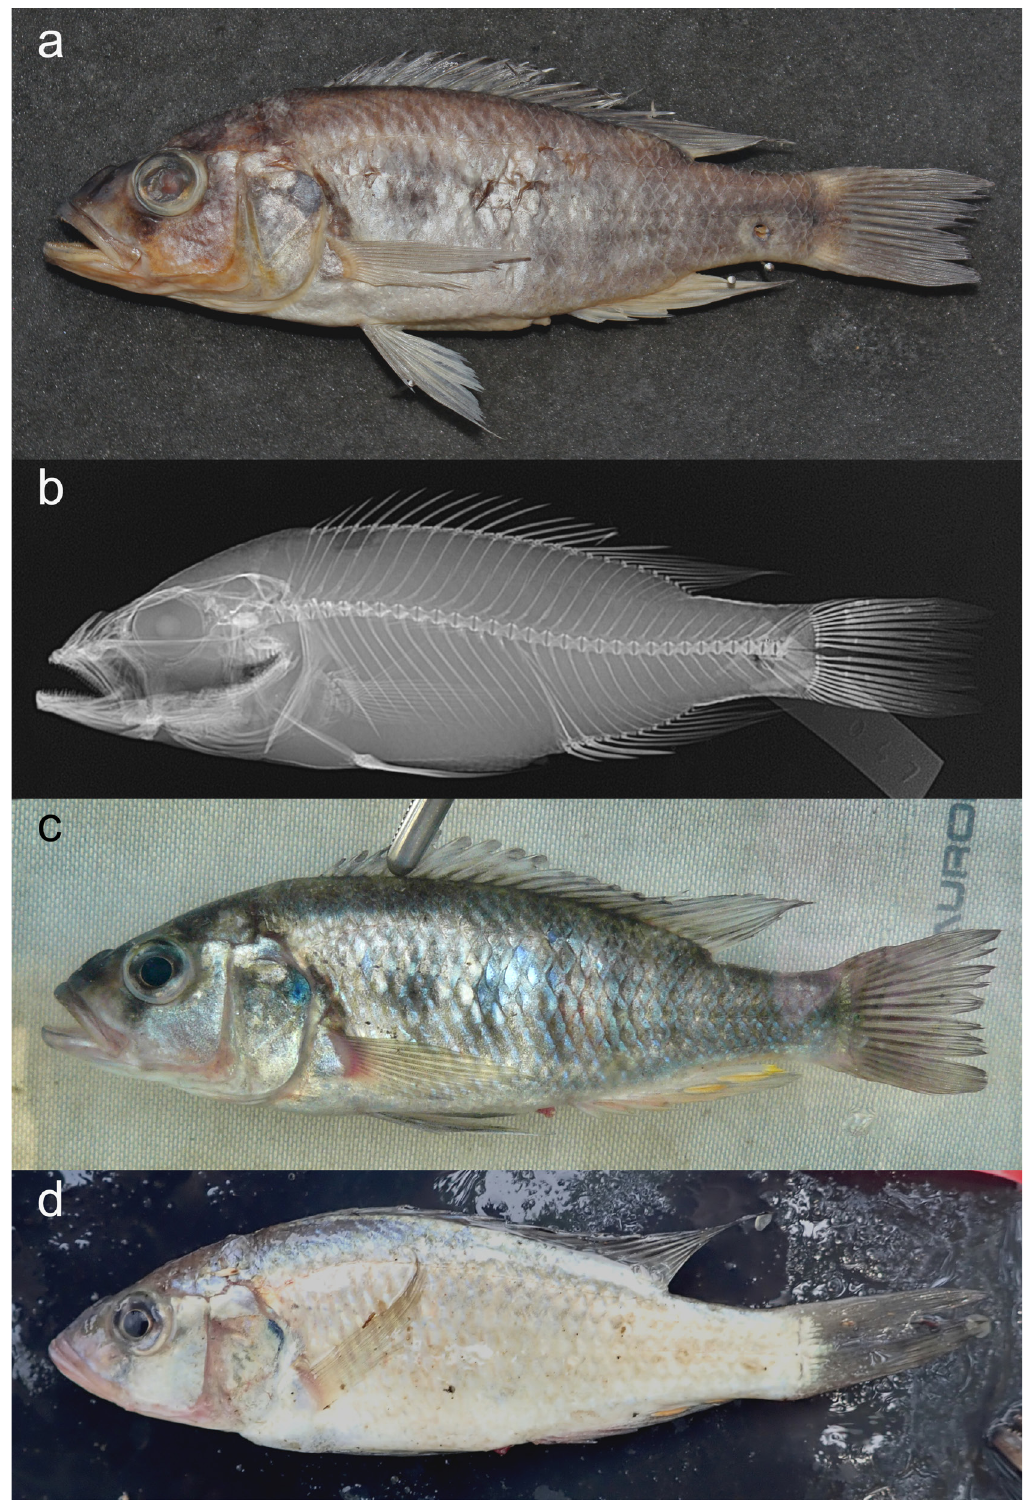
Fig. 30. Haplochromis curvidens sp. nov. a . Photograph of preserved holotype (RMCA 2016.035.P.0219; 112.0 mm SL). b . X-ray image of holotype. c – d . Photographs of freshly caught specimens. c . Holotype, an adult male. d . Female (RMCA 2018.008.P.0340); 90.2 mm SL) to illustrate the live colour patterns. The contrast was slightly